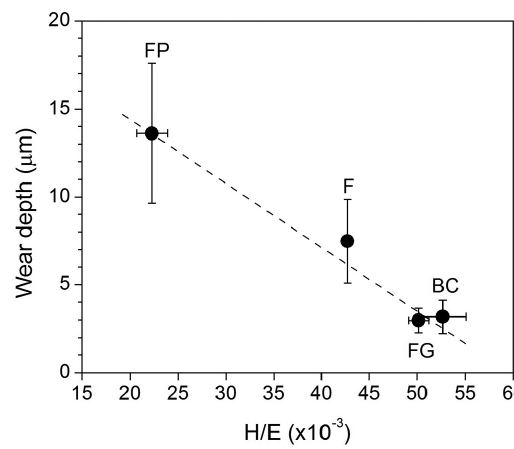
Figure 7. Wear depth as a function of H/E ratio for the tested sealants: Fortify Plus ® (FP), Fortify ® (F), FillGlaze ® (FG) and BisCover ® (BC). Dashed line is a guide to the